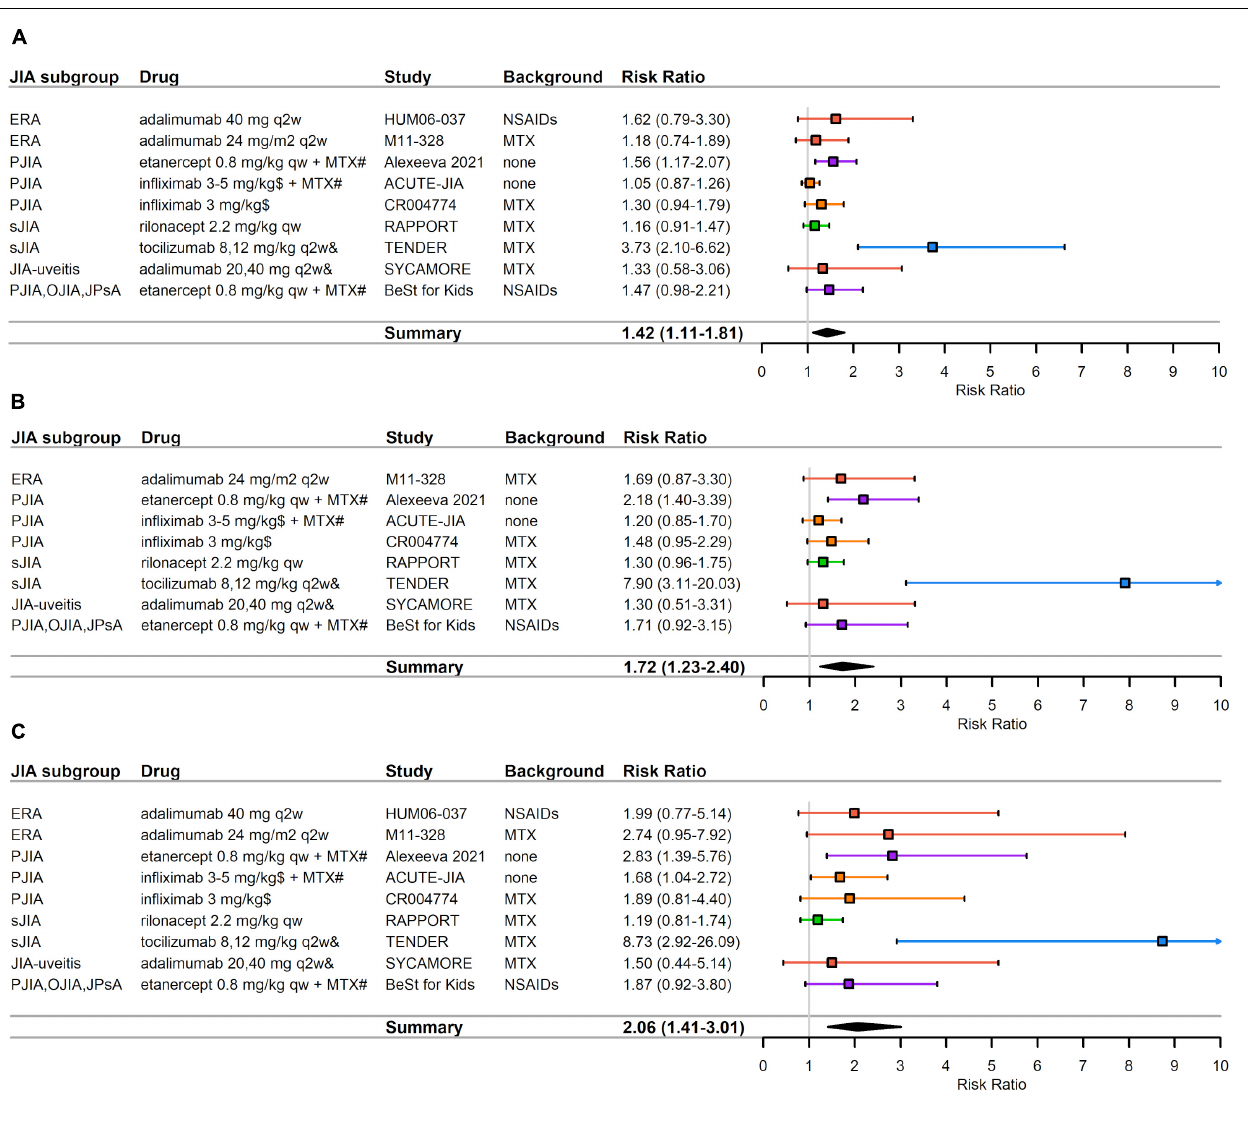
FIGURE 3 | RCTs that reported efficacy data at month 3 (e.g., weeks 12–14). (A) ACR Pedi 30 data (B) ACR Pedi 50 data (C) ACR Pedi 70 data. RRs—mean represented by the square—were calculated as % response in bDMARD or JAK inhibitor arm divided by % response in control arm. Overall effect estimate is represented by the diamond, which width shows the confidence intervals for the overall estimated effect estimate. Further, 95% CIs for RRs—represented by the whiskers—were computed utilizing the exact method. All CIs that did not include 1 indicated significant effects. Experimental treatment is preferred when RR > 1. ACR Pedi, American College of Rheumatology pediatric responses; eOJIA, extended oligoarticular juvenile idiopathic arthritis; ERA, enthesitis-related juvenile idiopathic arthritis; JIA, juvenile idiopathic arthritis; MTX, methotrexate; NSAID, non-steroidal anti-inflammatory drugs; PJIA, polyarticular juvenile idiopathic arthritis; PsA, psoriatic juvenile idiopathic arthritis; qw, every week; q2w, every 2 weeks; q4w, every 4 weeks; q6w, every 6 weeks; sJIA, systemic juvenile idiopathic arthritis; RR, risk ratio. # Compared against methotrexate monotherapy instead of placebo. $ Weeks 0,2,6,q6w for ACUTE-JIA study and weeks 0,2,6 for CR004774